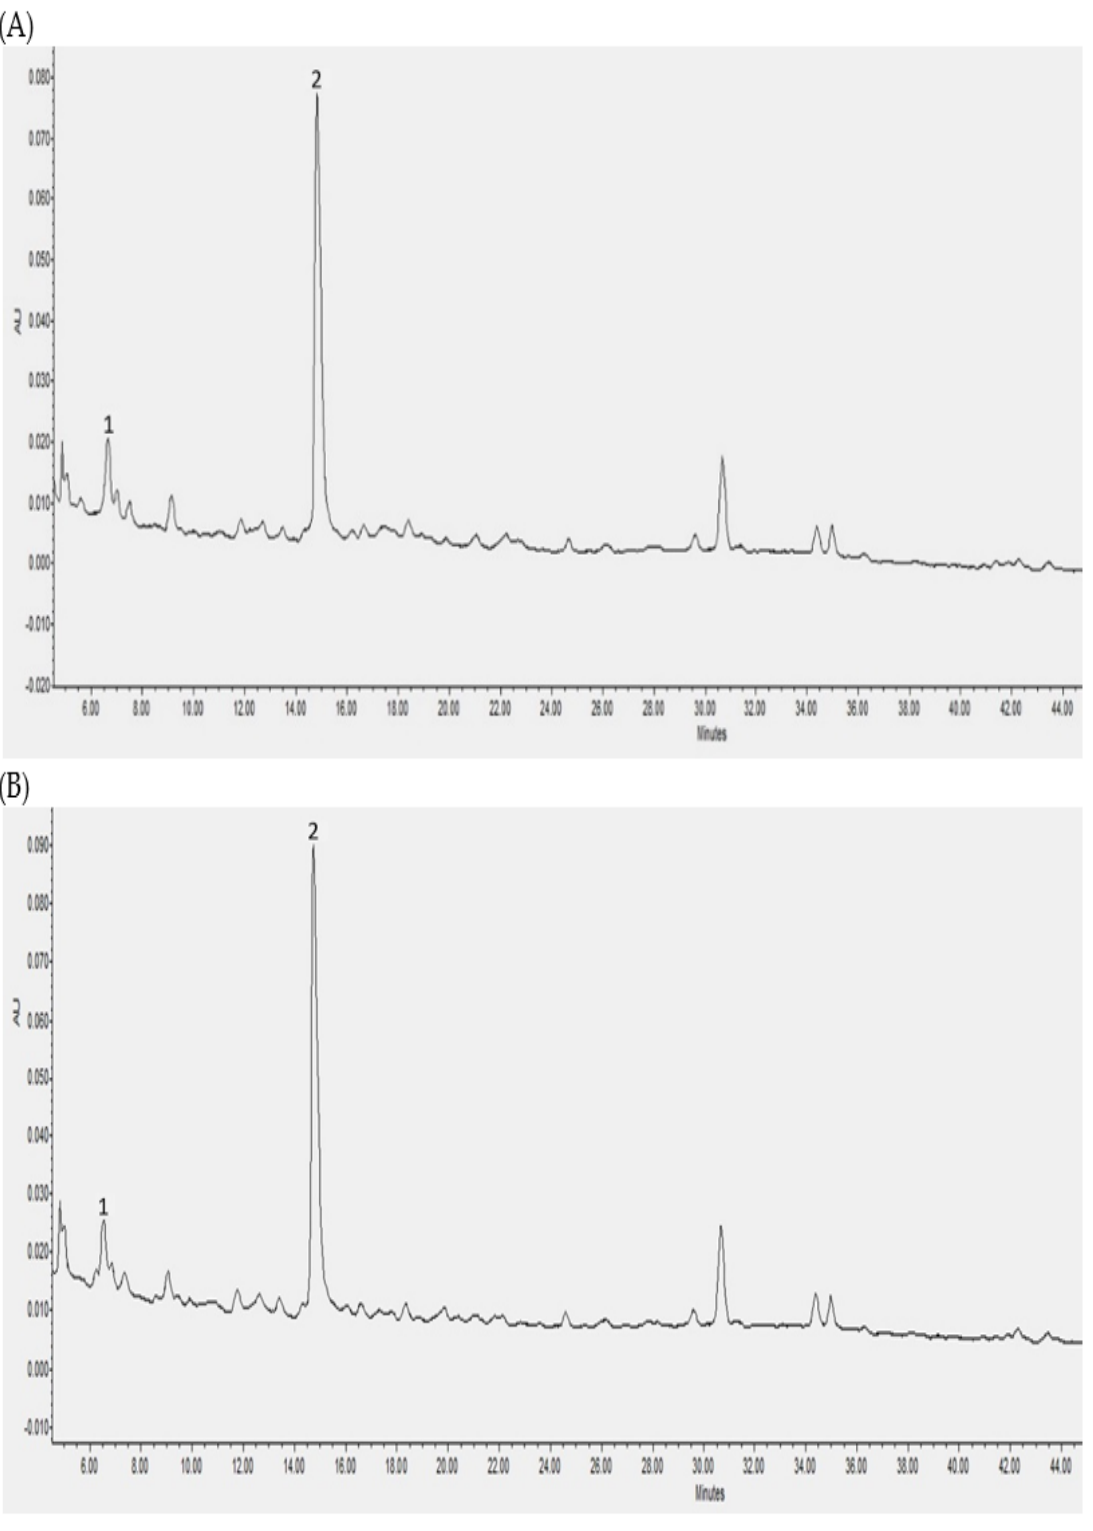
Figure 4. HPLC chromatograms of fermented fractions of chicory; ( A ) Soluble fraction of chicory after 12 h fermentation, ( B ) Soluble fraction of chicory after 24h fermentation. Polyphenols identified are (1) Pyrogallol, and (2) Procyanidin B2.